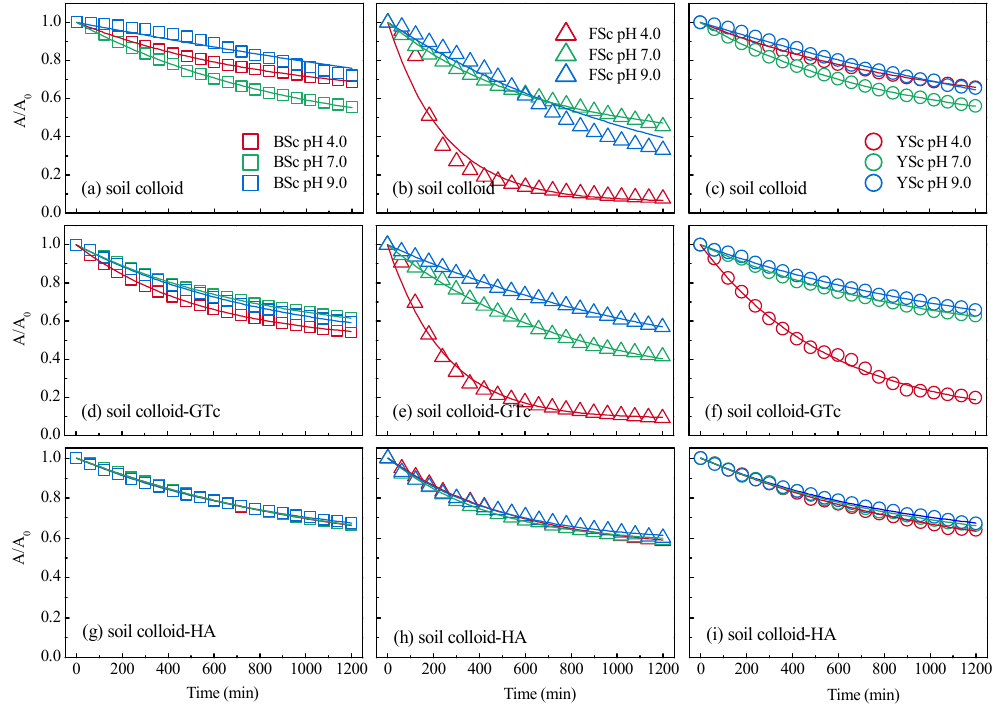
Figure 1. Sedimentation kinetics at pH 4.0 (red symbols), 7.0 (green symbols), and 9.0 (blue symbols) for ( a – c ) soil colloids, ( d – f ) soil colloids–goethite colloids (GTc), and ( g – i ) soil colloids–humic acid (HA). Treatments with ( a , d , g ) black soil colloids (BSc) (squares), ( b , e , h ) fluvo-aquic soil colloid (FSc) (triangles), and ( c , f , i ) yellow soil colloids (YSc) (circles). The concentrations of GTc and HA were both 25 mg L − 1 . Symbols show the observed data and the lines indicate the simulation fitting.